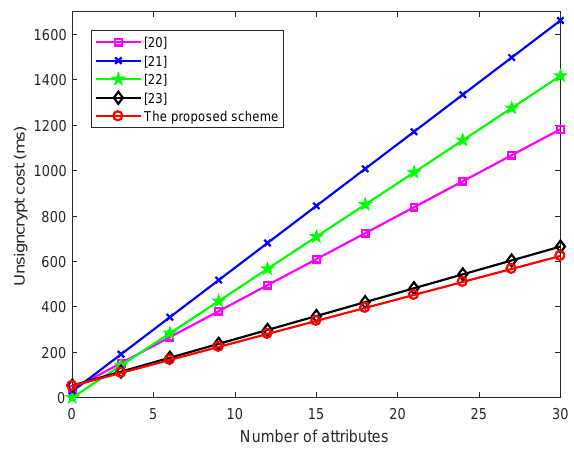
Figure 5. Unsigncrypt cost with the number of